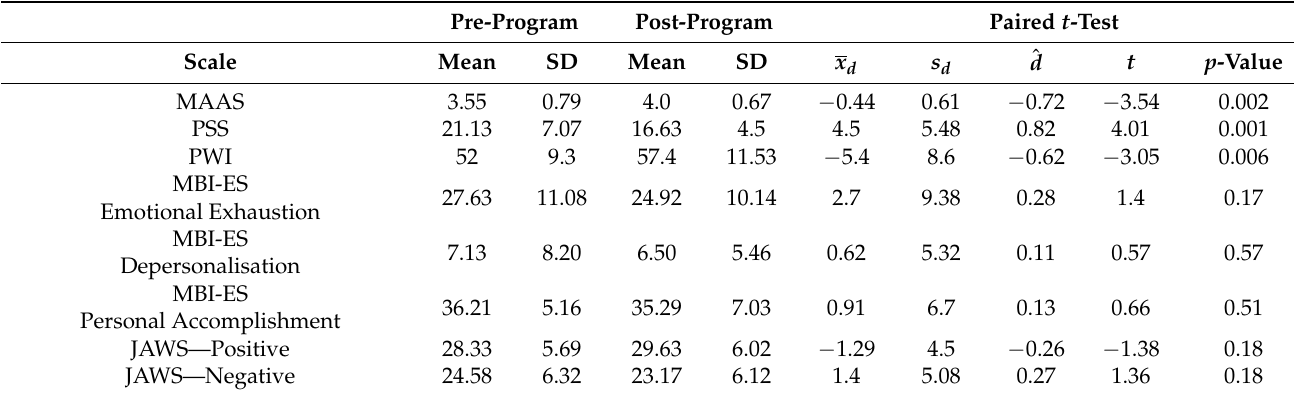
Table 5. Paired sample t -test results summary